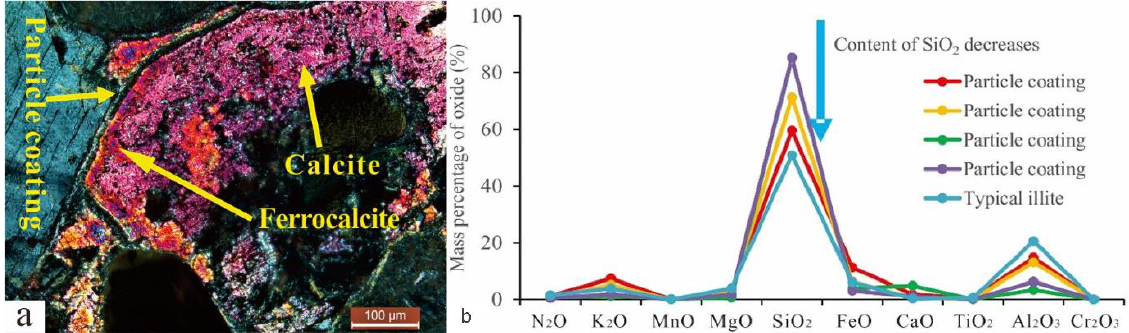
Figure 8. ( a ) The particle coating is coated with two-stage calcite, Q9-3, 2174.8 m. ( b ) Element distribution characteristics of particle coating and typical illite.